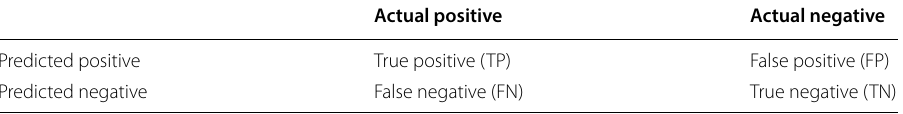
Table 1 Confusion